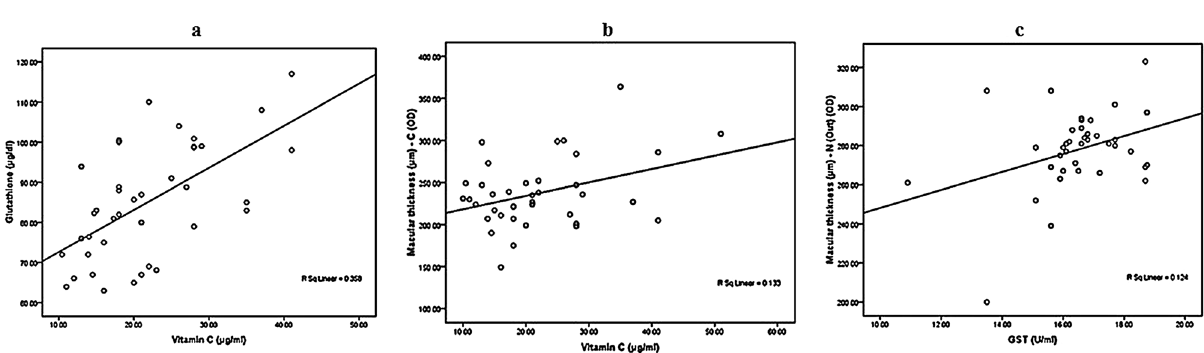
Figure 1. Correlation between (a) vitamin C (μg/ml) and glutathione (μg/dl); (b) vitamin C (μg/ml) and macular thickness (µm)—C (OD); (c) GST (U/ml) and macular thickness (µm)—N (Out) (OD) with best fit line curve (positive correlation).